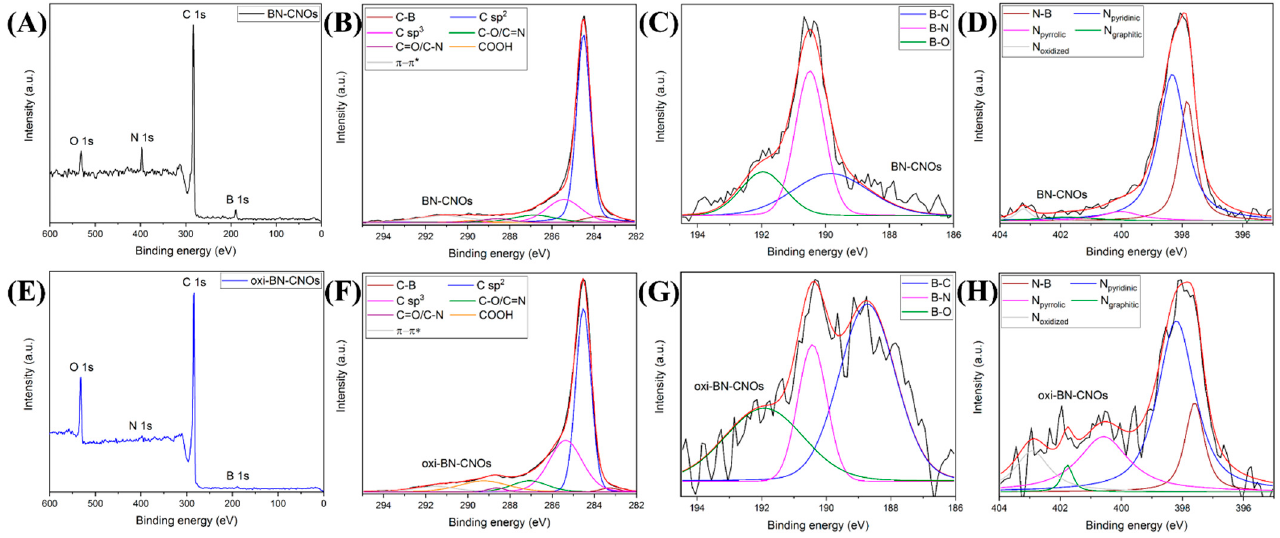
Figure 3. XPS survey ( A , E ) and high-resolution C 1s ( B , F ), B 1s ( C , G ), and N 1s ( D , H ) XPS spectra of BN-CNOs (upper panel) and oxi-BN-CNOs (lower panel), including peak deconvolution and experimental (black) and fitting curves (red).